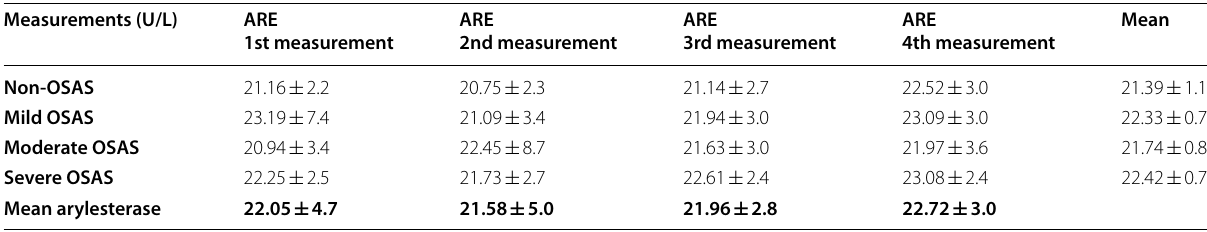
Table 5 Comparison of ARE levels between the groups